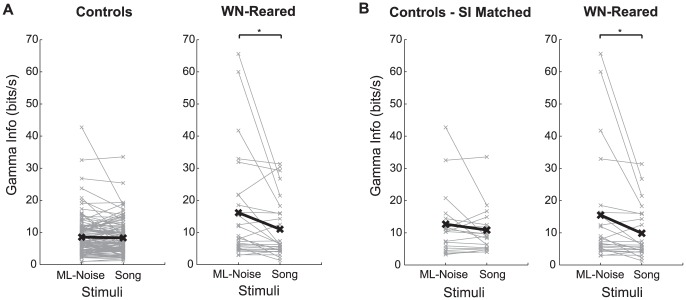
Single neuron information values greater for ML-Noise than song in wn-reared condition.A. Pairwise difference in Gamma Information rates (bits/s) for Song vs. ML-Noise estimated for single neurons for control birds (left) and wn-reared birds (right). Neurons in the auditory forebrain of wn-reared birds encode for ML-Noise more optimally than Song, while auditory neurons in control birds encode both ML-Noise and Song equally well. Even upon adjusting for firing rate differences using a general linear model, wn-reared neurons have higher Gamma Information values than the control neurons for both Song and ML-Noise, with a larger effect for ML-Noise (see Results). B. To control for potentially small differences in the types of receptive fields found in wn-reared birds compared to control birds, we also estimated the Gamma Information (bits/s) for single neurons in control birds that had similar (‘matched’) SIs to the receptive fields found in wn-reared birds. The pairwise difference in Gamma Information for Song vs. ML-Noise is still negligible in the matched control case, while the neurons in wn-reared birds encode for ML-Noise more optimally than Song. Even upon adjusting for firing rate differences using a general linear model, neurons from the wn-reared condition still have higher Gamma Information values than the matched control neurons for both Song and ML-Noise, and once again the effect size is larger for the ML-Noise stimuli than for the Song stimuli (see Results).